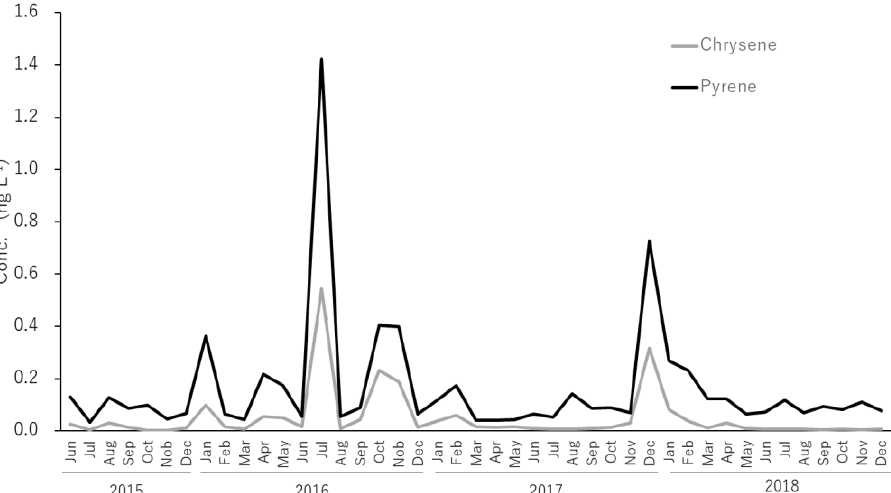
Figure 7. Temporal changes in the concentration of dissolved pyrene and christen in North Nanao Bay during 2015–2018.